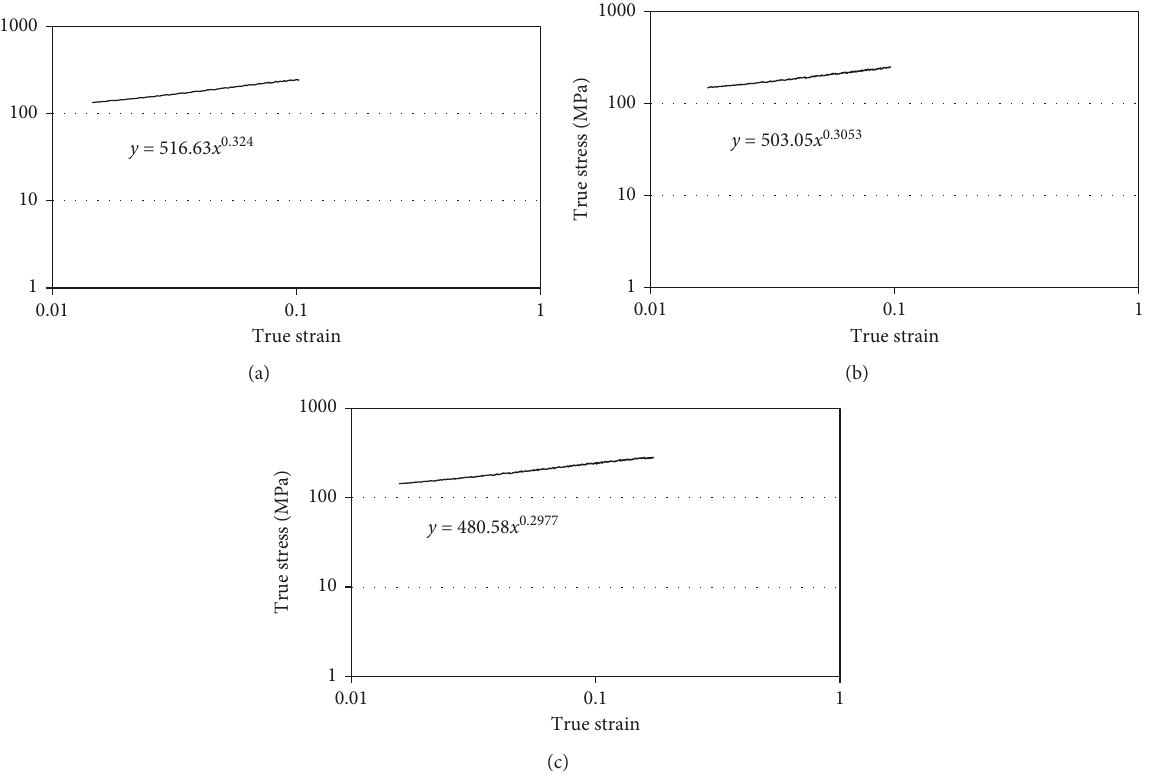
Figure 15: True stress-true strain plot log-log scale of FSW samples welded at different feed rates: (a) 36mm/min; (b) 70mm/min; (c) 140mm/min.